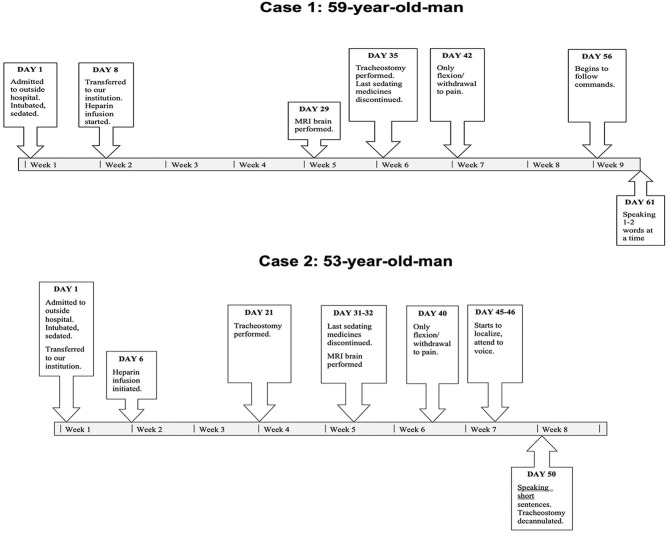
Timeline of events for both cases.